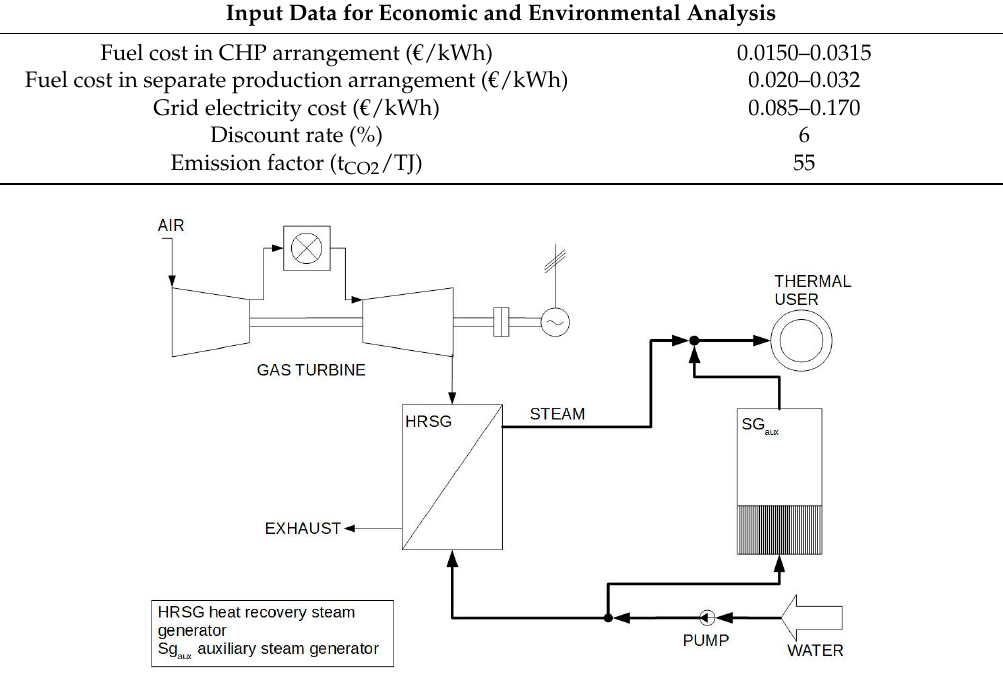
Figure 4. Scheme of the gas turbine cogeneration unit taken into consideration.